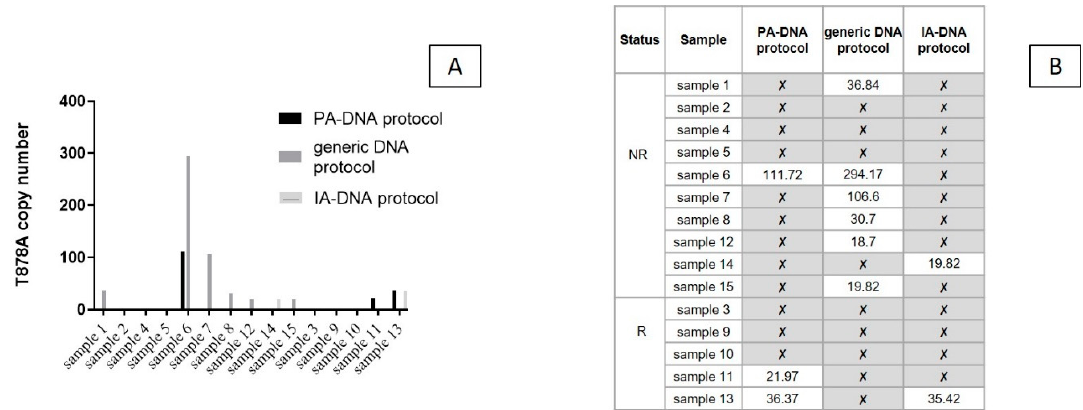
Figure 4. ( A ) AR T878A copies/mL identified with the column-based DNA purification (PA-DNA) protocol, the generic DNA protocol Kit and the IA-A protocol. ( B ) Results of the isolation for detection